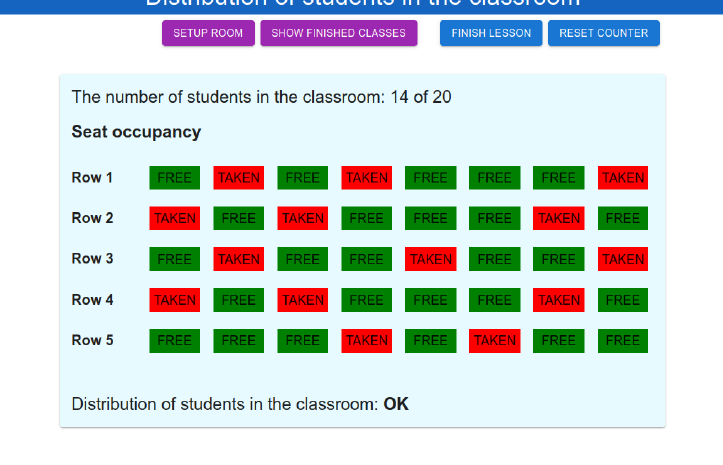
Figure 10. GUI home screen showing student distribution in the classroom.